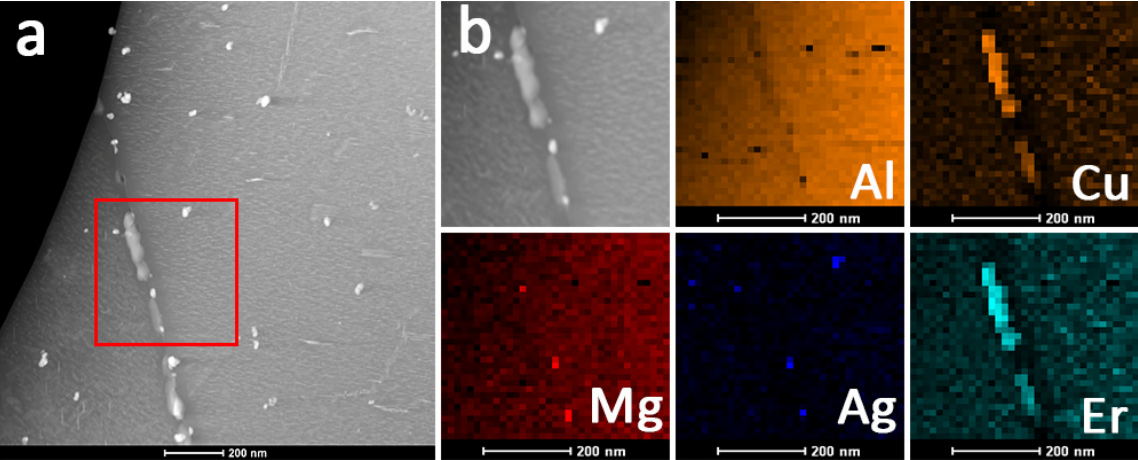
Figure 11. The ( a ) STEM-HAADF image and ( b ) corresponding EDS mapping of the microstructures of T6-tempered 0.09Er alloy after tensile test at 300 °C.